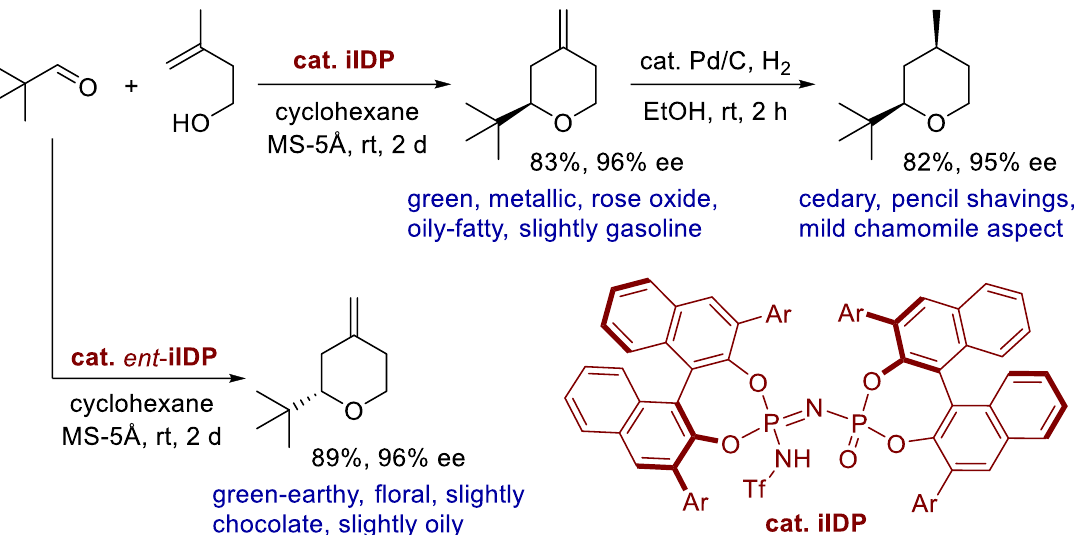
Scheme 13. Synthesis of O -heterocyclic fragrances via an enantioselective Prins reaction catalyzed by imino-imidodiphosphate